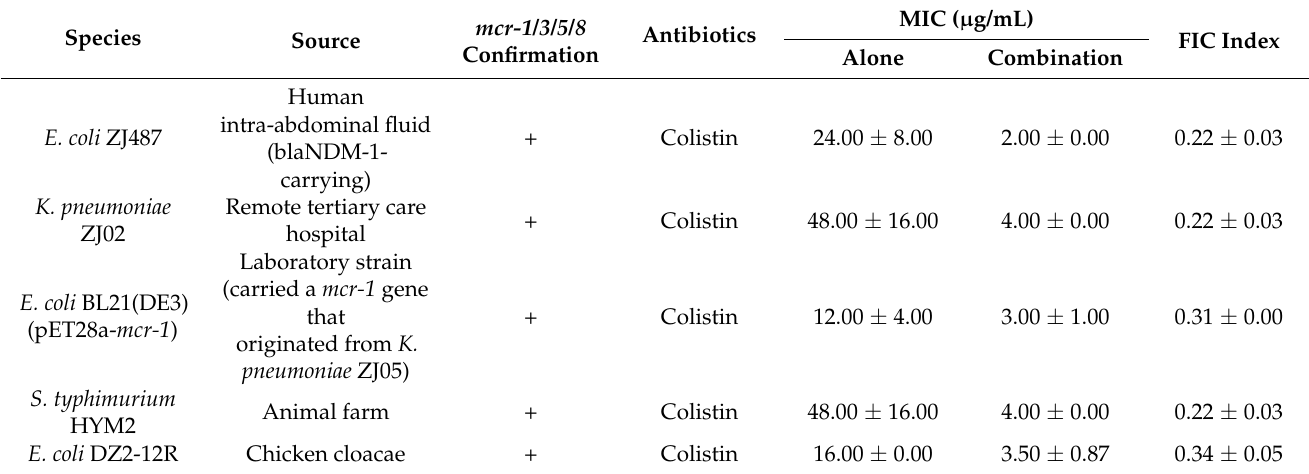
Figure 1. Pogostone rescues the activity of colistin. ( A – D ) Checkerboard MIC analysis showing the combined effect of pogostone and colistin against MCR-1-positive strains ( E. coli BL21 (DE3) (pET28a- mcr-1 ), E. coli ZJ487, K. pneumoniae ZJ02 and S. typhimurium HYM2). ( E – H ) The growth curves E. coli BL21 (DE3) (pET28a- mcr-1 ), E. coli ZJ487, K. pneumoniae ZJ02 and S. typhimurium HYM2 under different concentrations of pogostone (0, 32–512 µg/mL). ( I – L ) Time-killing assays of different combinations of pogostone and colistin compared with single compound or control treatments (only medium) against E. coli BL21 (DE3) (pET28a- mcr-1 ), E. coli ZJ487, K. pneumoniae ZJ02, and S. typhimurium HYM2. Values represent the averages of three independent experiments. Table 1. MIC values of colistin alone or combination therapy against each of the tested bacterial